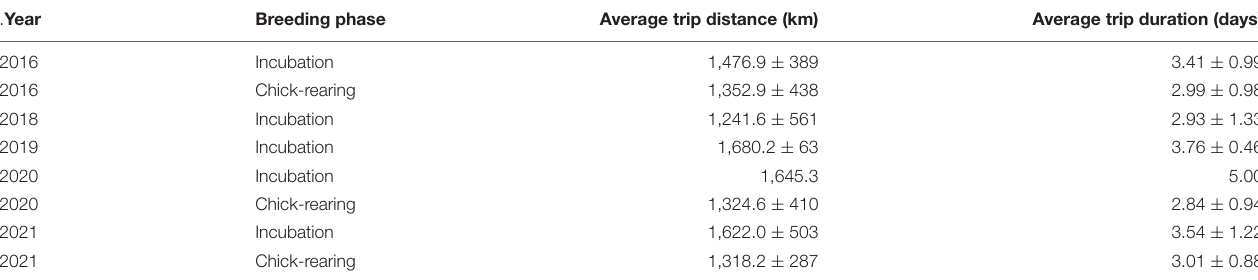
TABLE 2 | Average trip distance ± SD and duration ± SD by year and breeding phase for Leach’s Storm-Petrels breeding at Gull Island, Witless Bay, Newfoundland and Labrador, Canada from 2016–2021. .